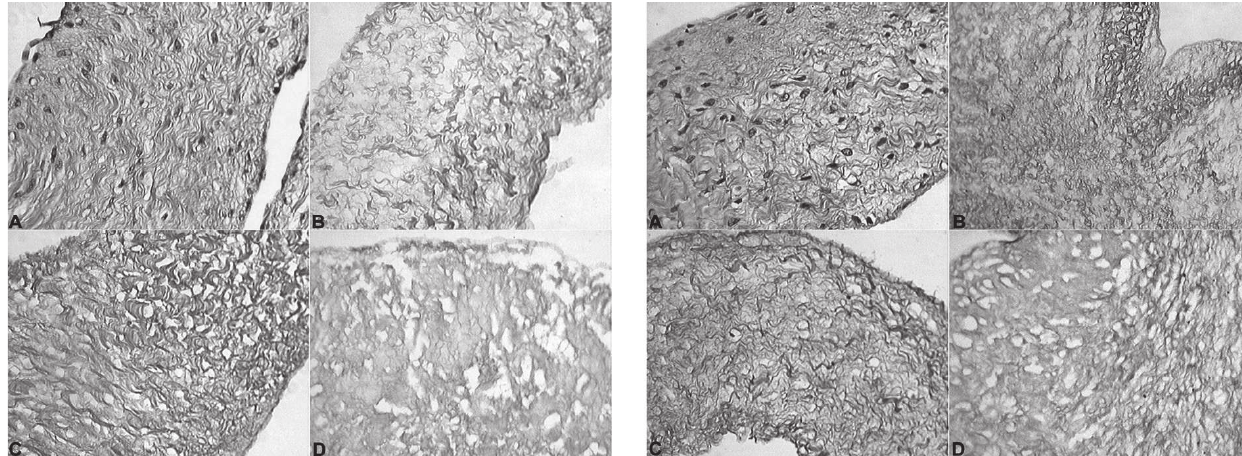
Fig. 2 - À esquerda: análise qualitativa da matriz extracelular de cúspides pulmonares submetidas a processo de descelularização. A – Controle Pré - Descelularização. B – DOA 1%; C – SDS 0,1% e D – SDS 0,3%. À direita: análise qualitativa da matriz extracelular de cúspides pulmonares criopreservadas e submetidas a processo de descelularização. A – Controle: criopreservado e não submetido a processo de descelularização. B – DOA 1%; C – SDS 0,1% e D – SDS